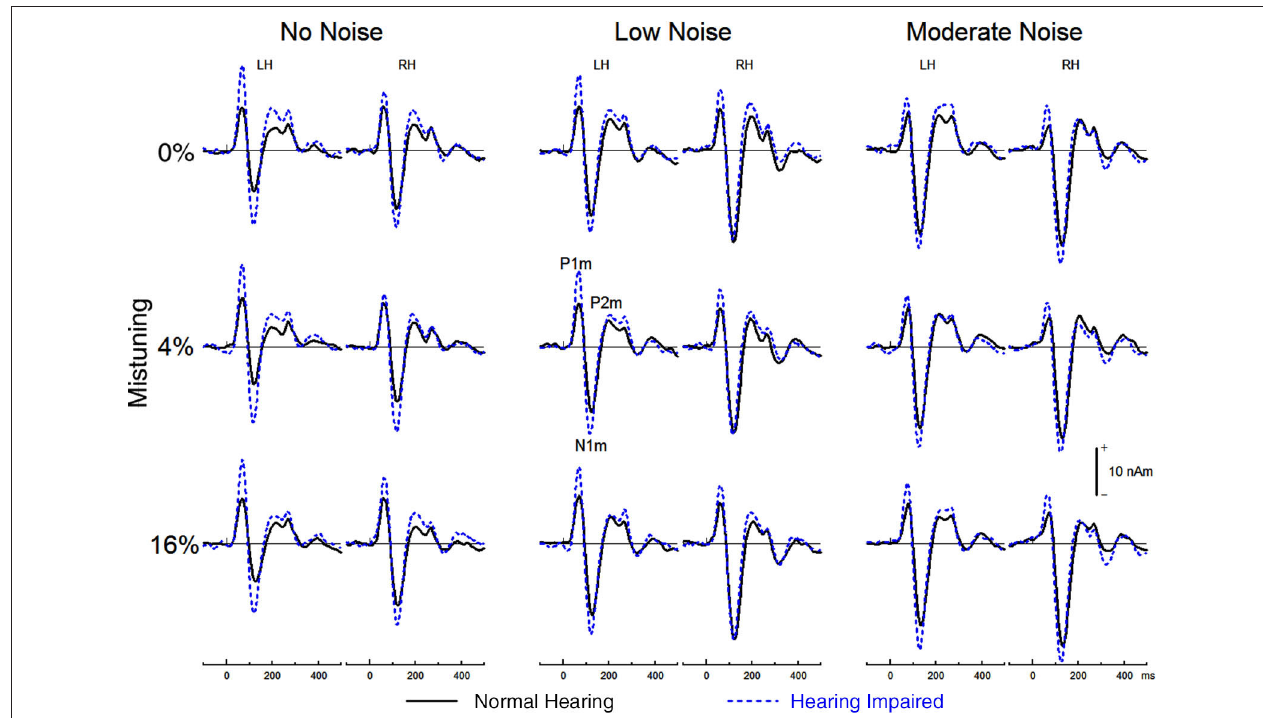
FIGURE 5 | Group mean source waveform from the left hemisphere (LH) and the right hemisphere (RH) for tuned (top) and mistuned stimuli.